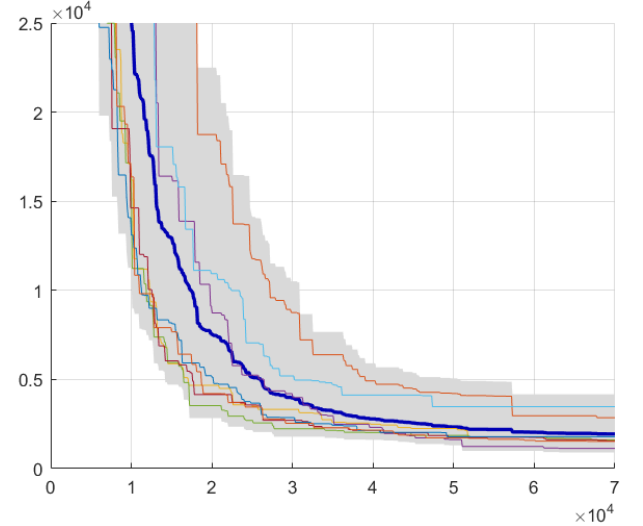
Figure 5. Convergence curves for the optimization process: the blue thick line is the average conver- gence, and the gray region identifies the 95% confidence interval of the population convergence.